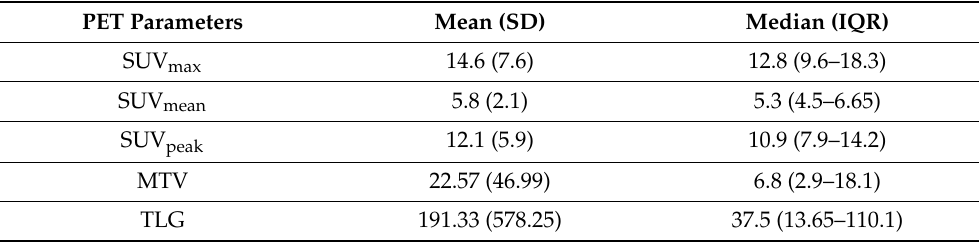
Table 2. Mean and median values of metabolic and volumetric parameters of the primary breast tumors of the 111 TNBC patients upon PET/CT.